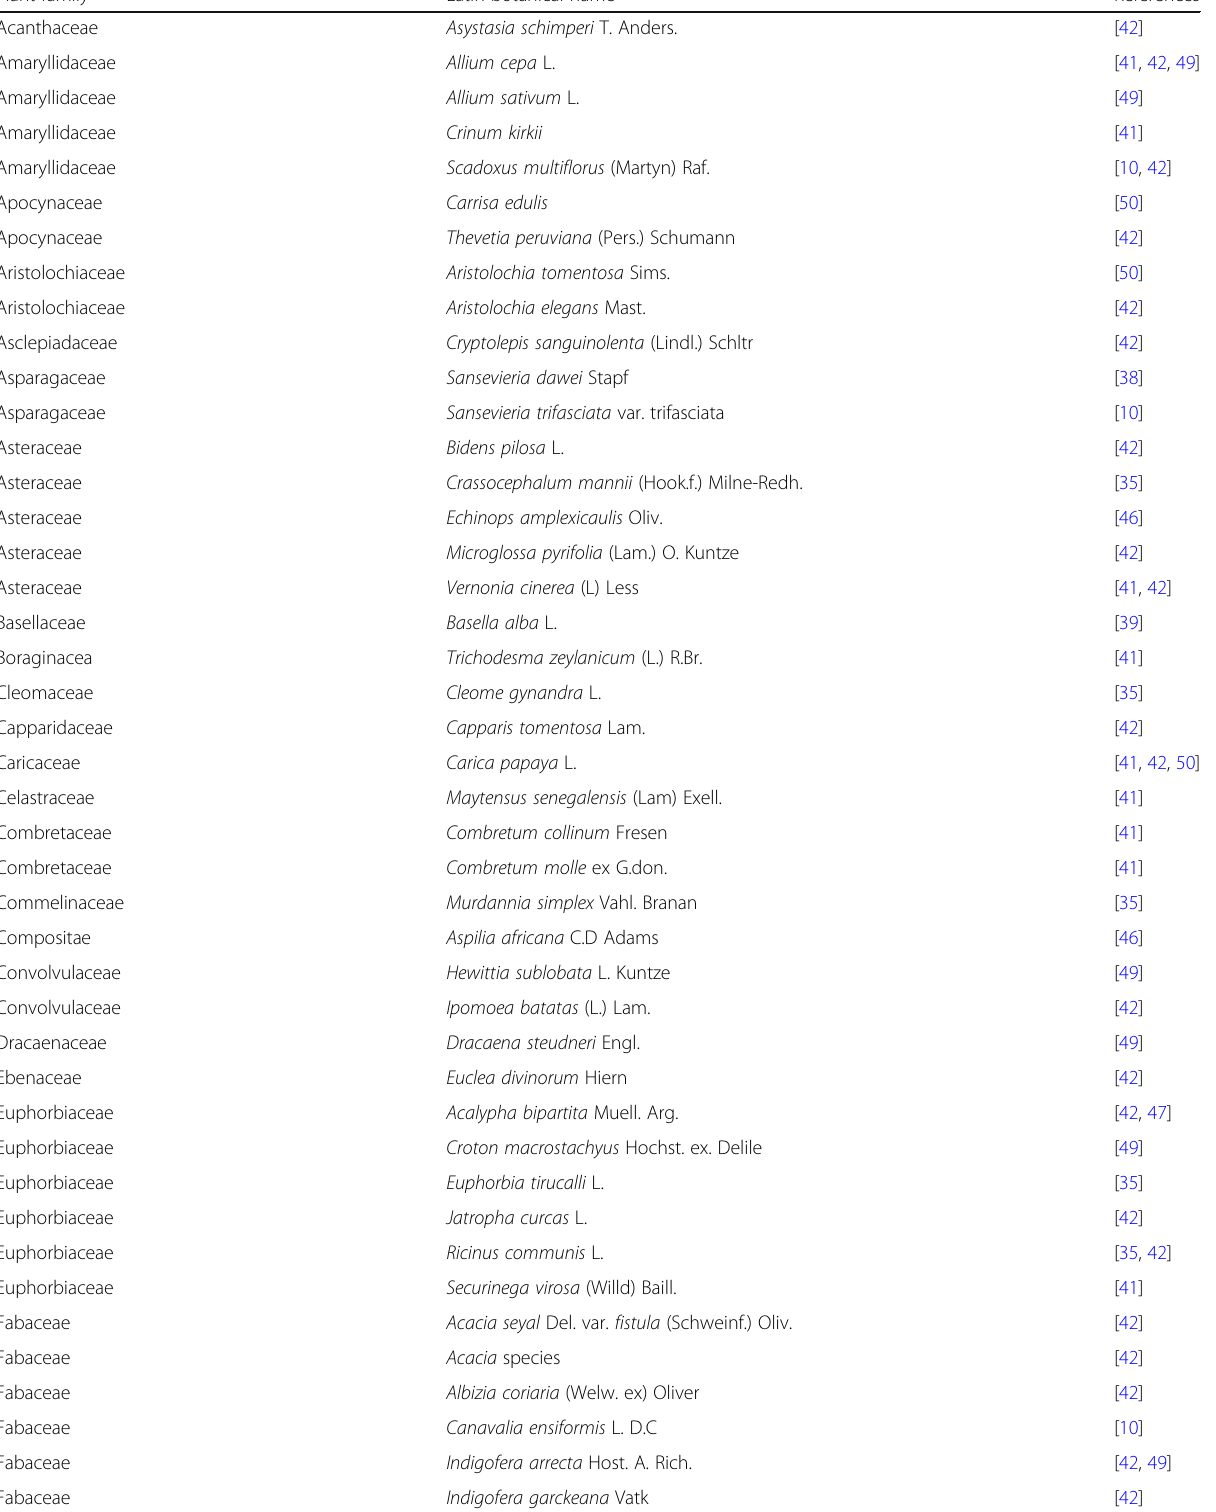
Table 1 Antivenin plants used in rural communities of Uganda Plant